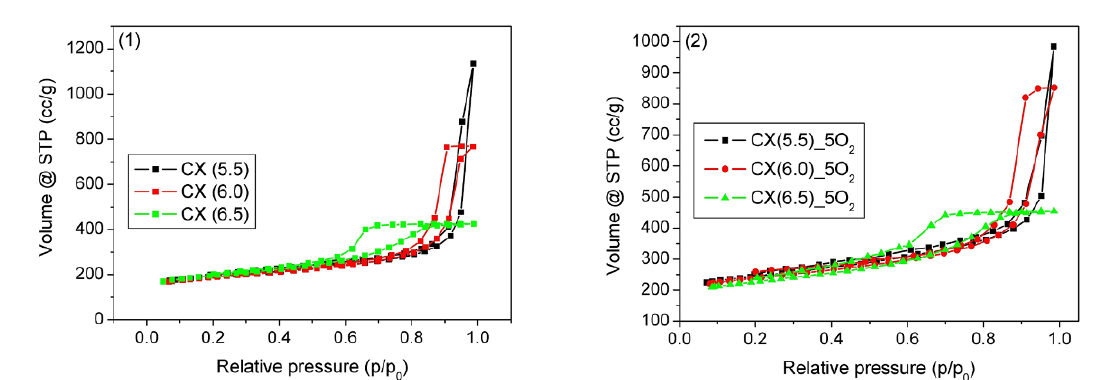
Figure 1. N adsorption-desorption isotherms of (1) the CXs synthesized under different pH values and (2) those after oxygen activation. 2